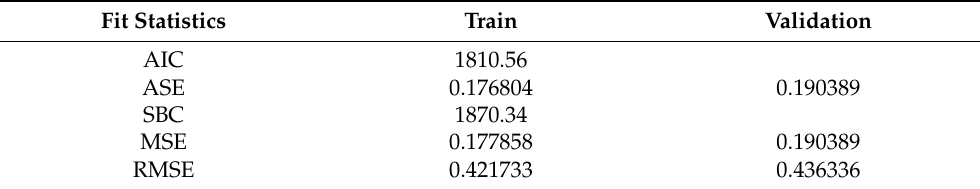
Table 2. Model selection criteria.